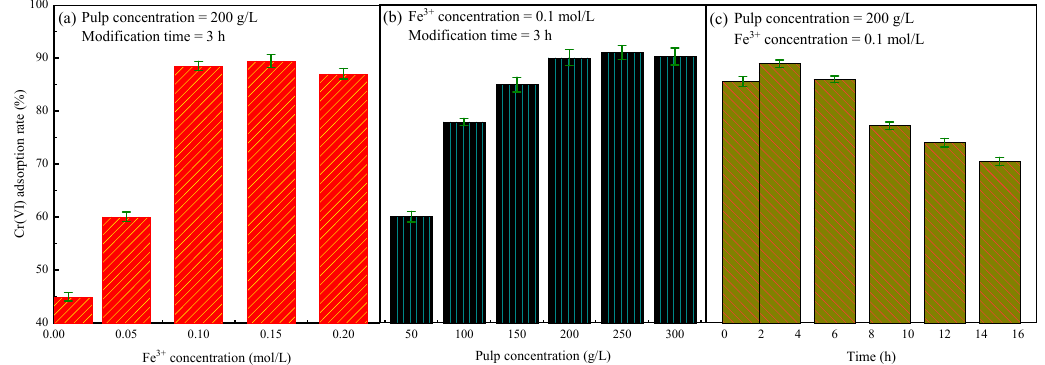
Figure 3. The modification effects of rectorite under three different factors. ( a ) Fe 3+ concentration; ( b ) pulp concentration and ( c ) modification time.